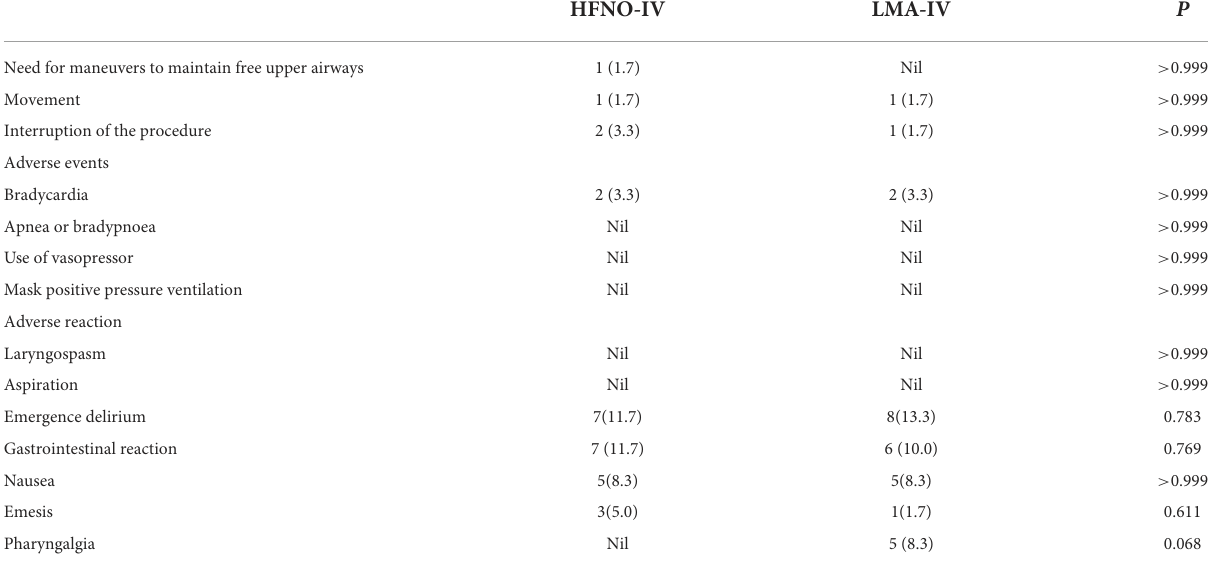
TABLE 3 Risk and adverse events *